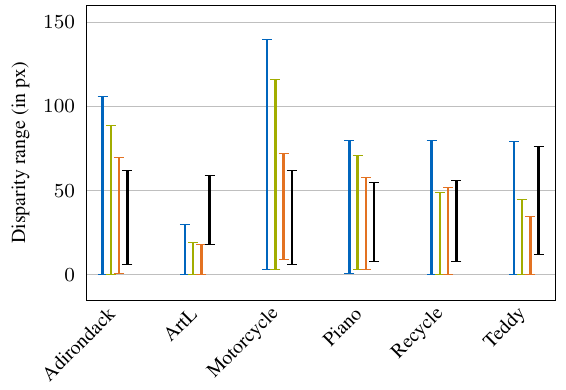
Figure 9. Disparity histograms for ground truth (left) and mono-depth prediction (right) for Motorcycle sample